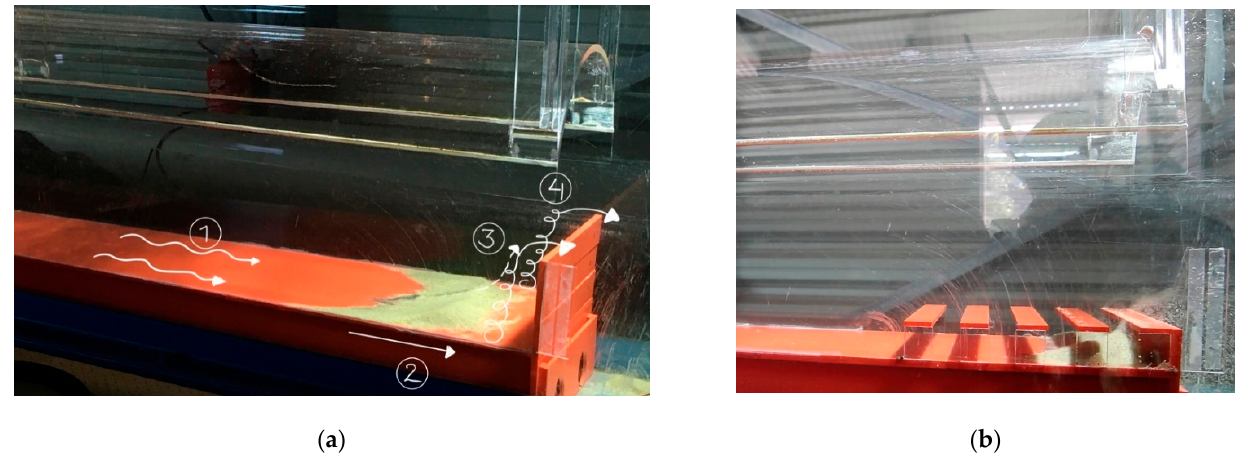
Figure 12. ( a ) Weir heightening (triple height), particle transport modes; (1) bedload transport, (2) dune creation and transport, (3) resuspension at dune tip with lifting over weir, (4) vortex creation with particle lifting. ( b ) Particle transport under ribs and over weir, showing insufficient trapping capacity without the ramp.